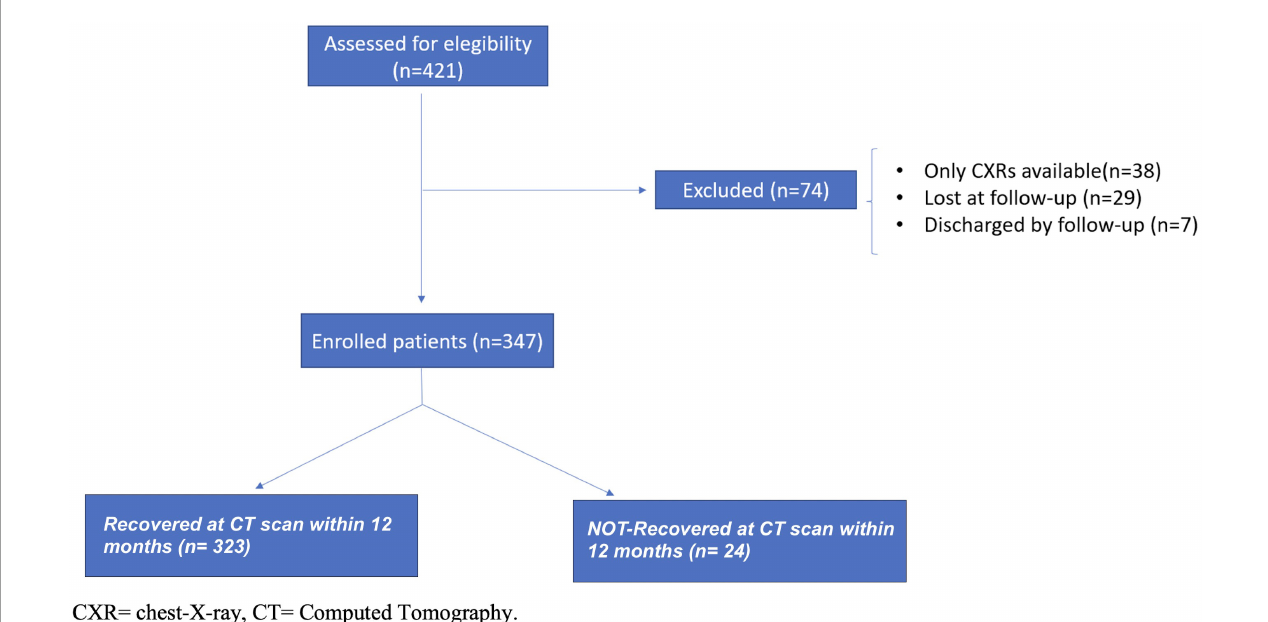
FIGURE1 Enrollment flow-chart of patients discharged from hospital and included in the study